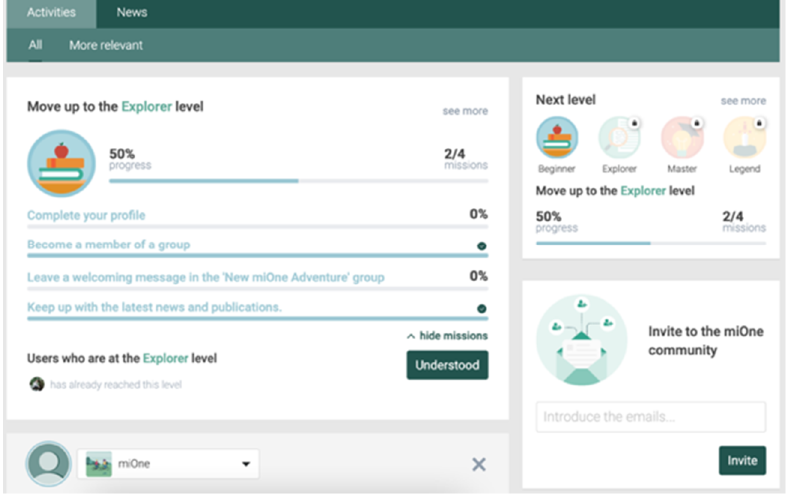
Figure 6. miOne’s homepage with the mission progress summary (Authors’ copyright).